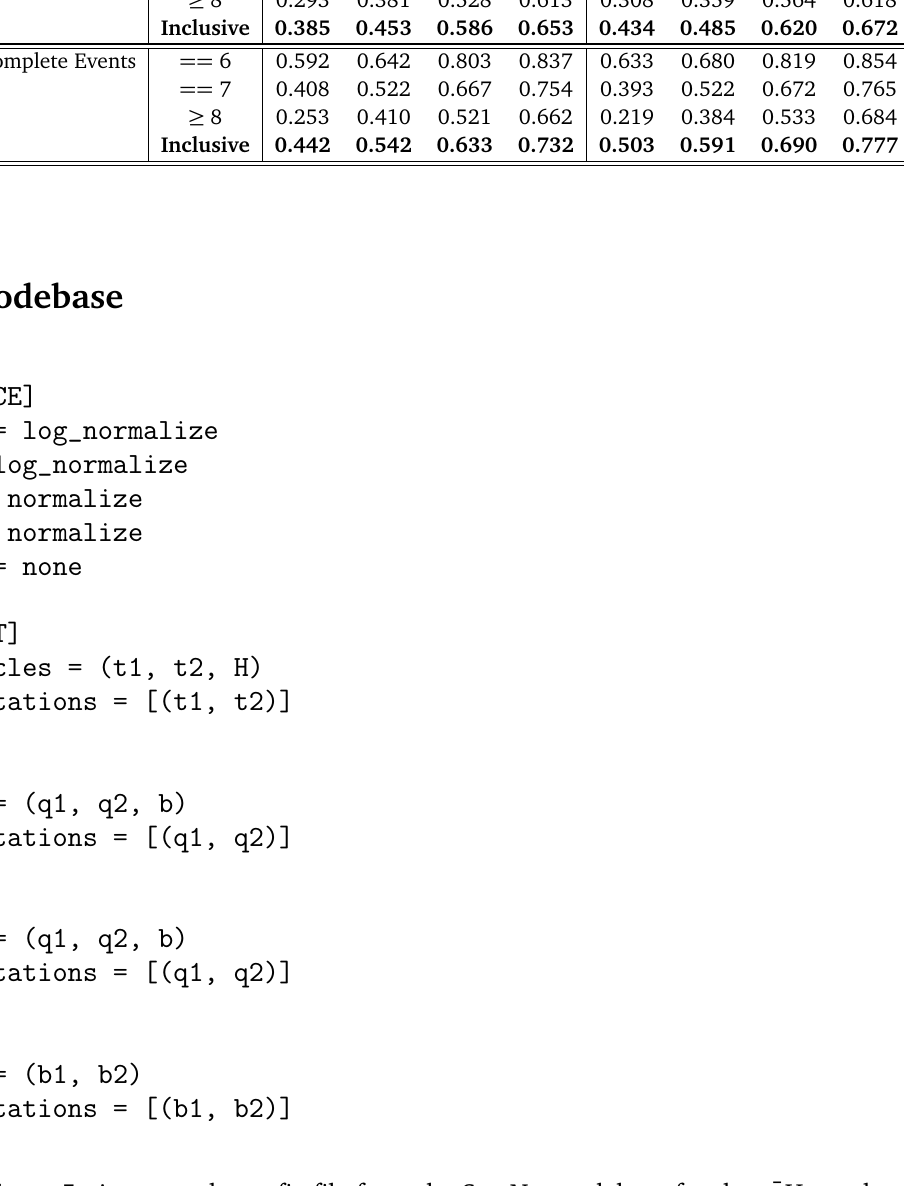
Figure 5: An example config file from the S PA -N ET codebase for the t ¯ tH topology. In order to minimise the overhead required for independent groups to verify our results